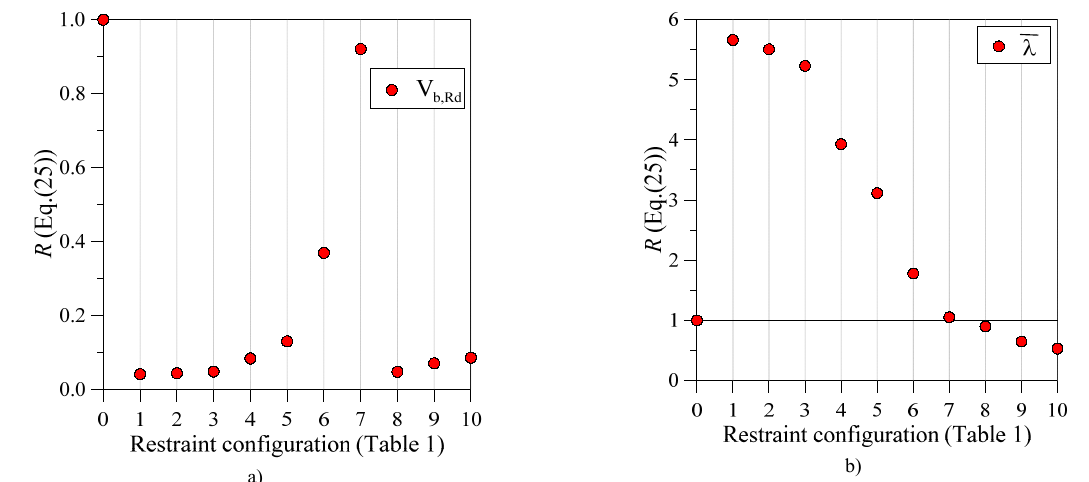
Fig. 10 Analytical comparative shear buckling calculations for a given glass wall geometry with several restraint typologies and subjected to a short term in-plane shear load. a) Design critical buckling load (Eq.(15)) and b) normalized slenderness ratio